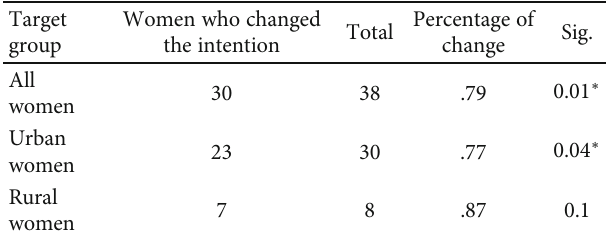
Table 2: Change of intention among primigravida women based on ratio